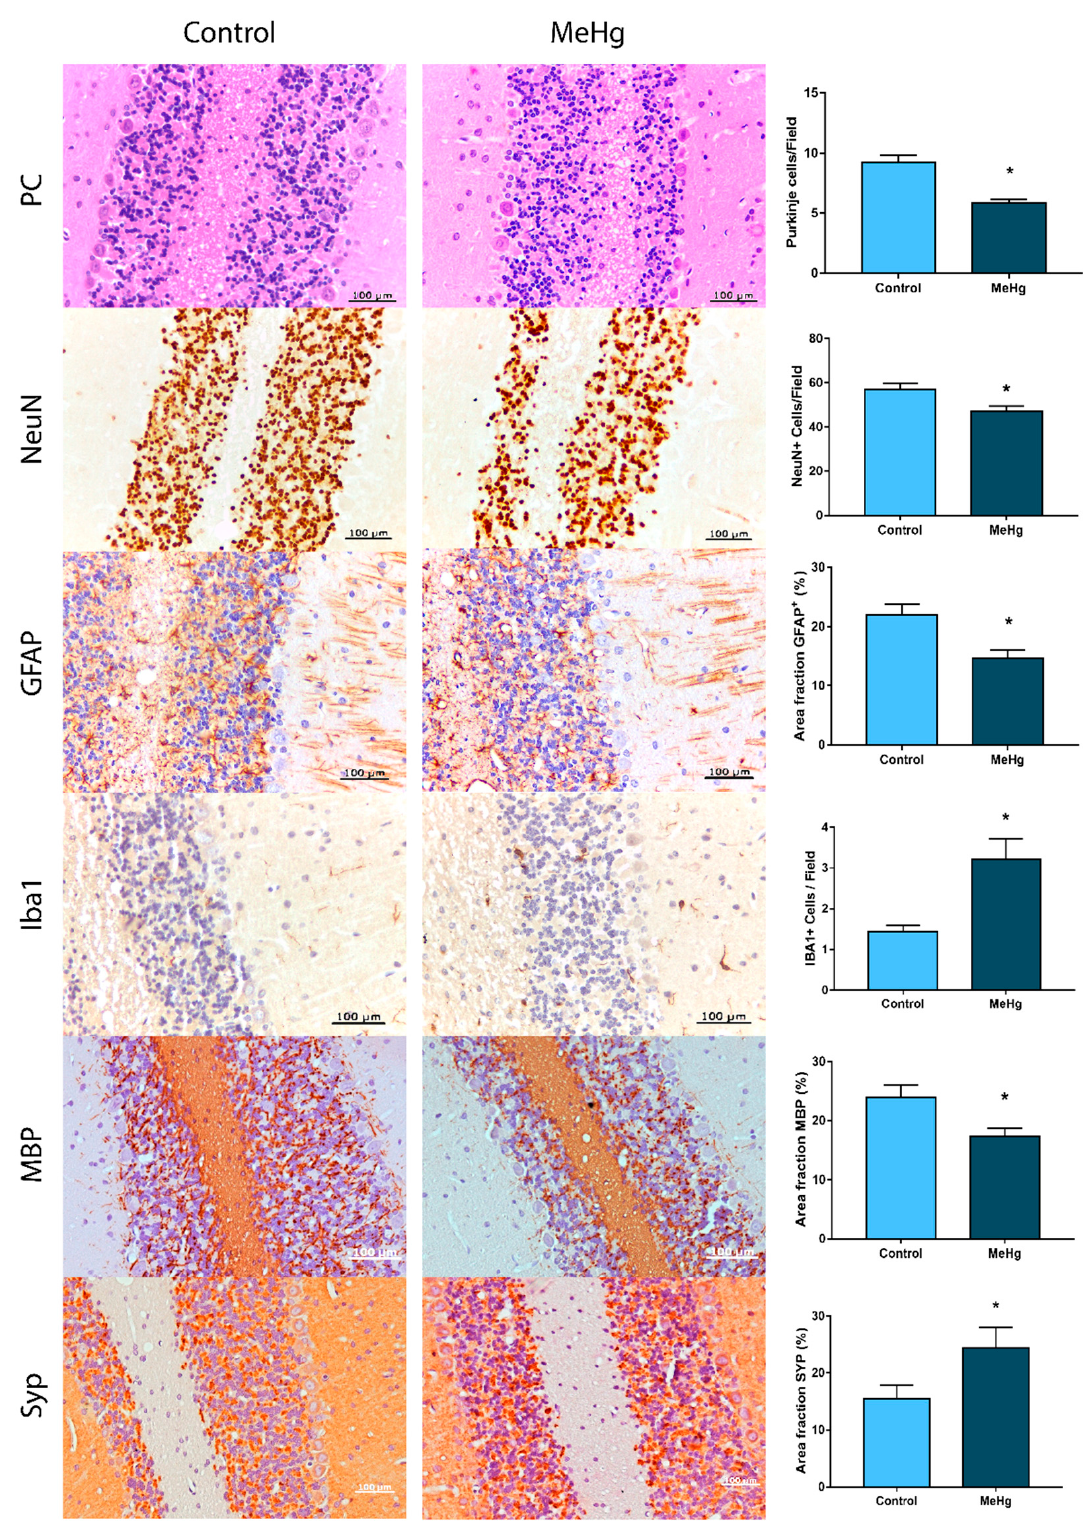
Figure 5. Effects of exposure to MeHg on the morphological integrity of cerebellums of Wistar rats. PC: Purkinje cells; NeuN: mature neurons; GFAP: glial fibrillary acidic protein; Iba1: microglia markers; MBP: myelin basic protein; Syp: synaptophysin. Results are expressed as means ± standard errors of the means (SEMs). The Student’s t -test was used to analyze the PC, NeuN, and Iba1 results, and the Mann–Whitney test was used to analyze the area fraction data. * p <